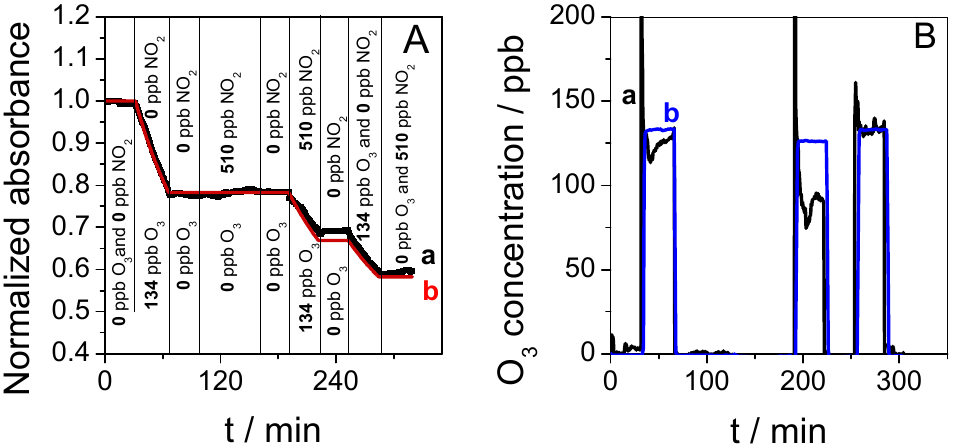
Figure 6. ( A ) Experimental (a, black) and model (b, red) curves showing the normalized absorbance as a function of time in the presence of 0 or 134 ppb of O 3 and 0 or 510 ppb NO 2 . ( B ) O 3 concentration measured as function of time with the O 3 sensor (a, black) and controlled values given by a benchtop O 3 analyzer (b, blue). The test was performed at 24 °C, with air at 50% RH passing through the Nafion ® tube at a flow rate of 350 mL min -1 and using a sampling time of 30 min.